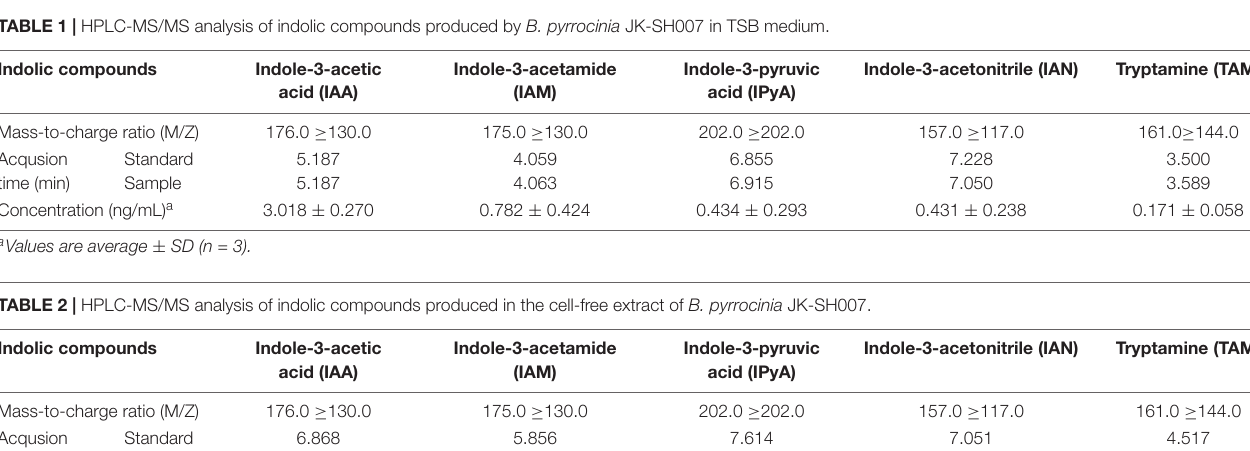
Mass-to-charge ratio (M/Z)